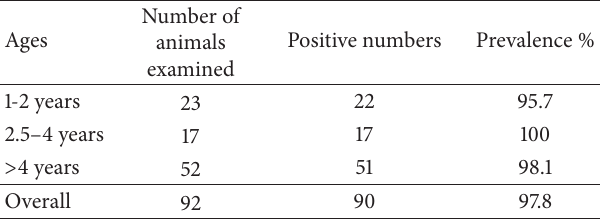
Table 2: Prevalence of recovered donkey parasites according to animal